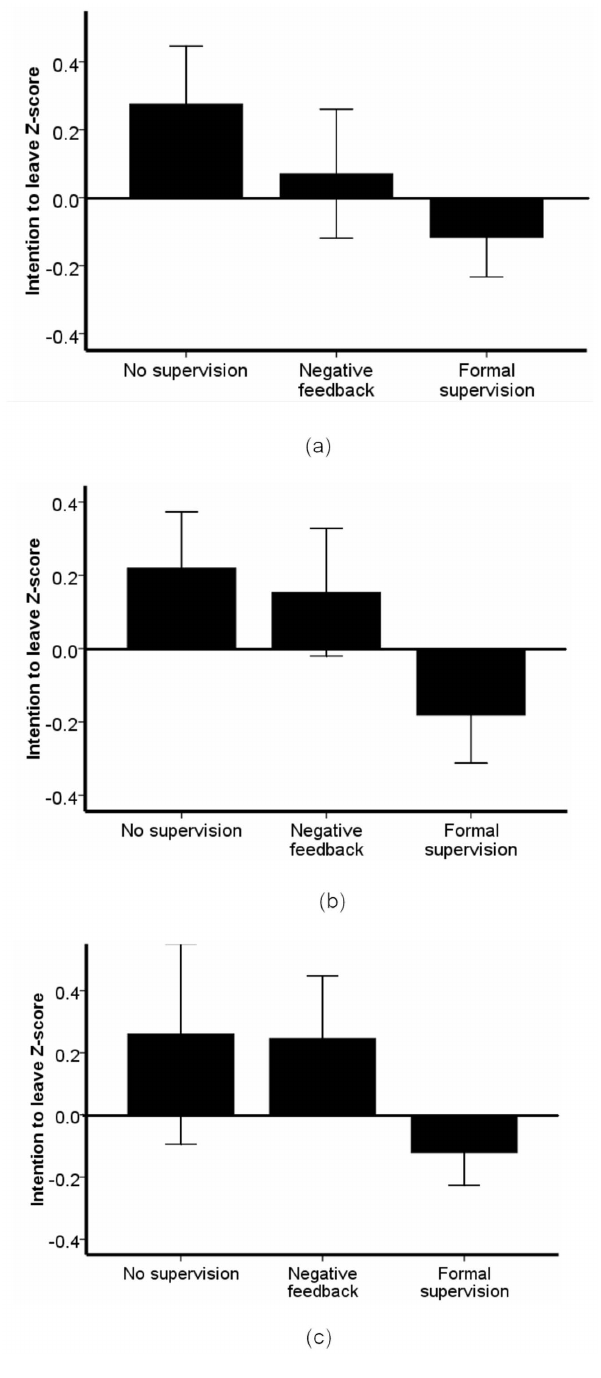
Figure 1. Intention to leave the workplace Z-scores as a function of an absence of supervision, negative feedback only, and formal supervision in: (a) Malawi, (b) Tanzania, and (c)